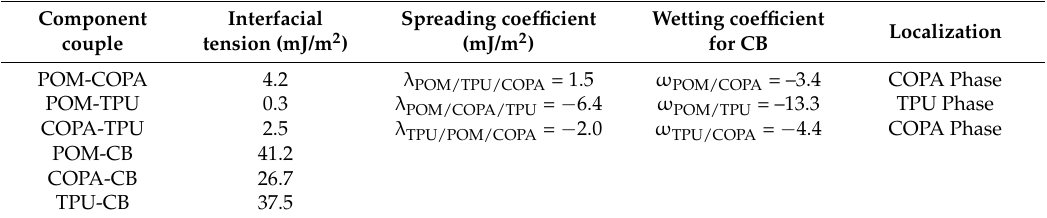
Table 2. Interfacial tensions, spreading coefficients and wetting coefficients at 200 ◦